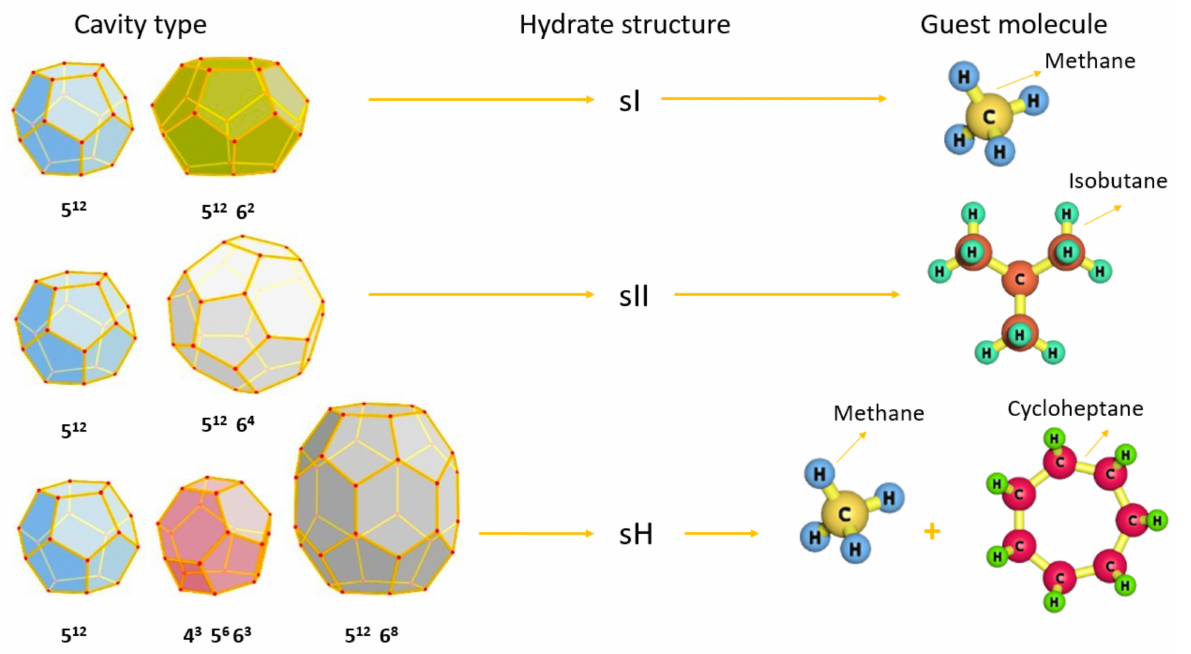
Figure 3. Gas hydrates cavity types and structures, along with the guest gas molecules that can occupy each hydrate